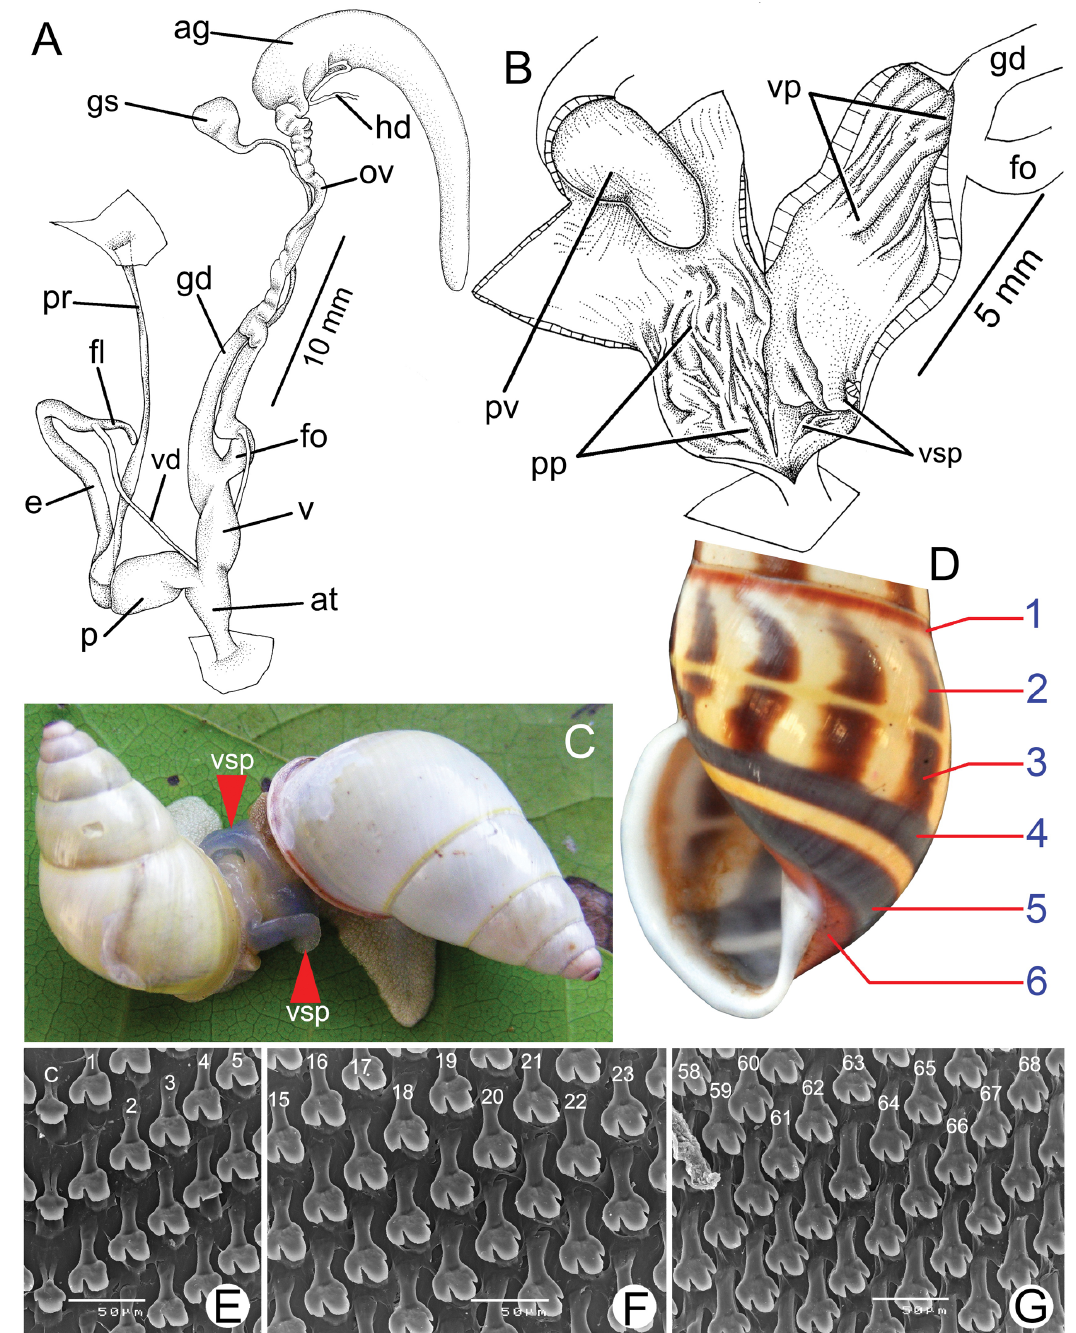
Fig. 8. Genitalia, mating pairs, shell banding formula and radula morphology. A–B . Amphidromus ( Syndromus ) contrarius (Müller, 1774) from Timor (ZMA). A . Genital system. B . Internal structures of penis and vagina. C . Mating pair of Amphidromus ( Syndromus ) sp., showing the protruded vaginal simulator pilaster (vsp, red arrows) and its possible function as a stimulating organ. D . Schematic drawing of shell banding, where the numbers 1 to 6 on the last whorl indicate the position of each band. E–G . Radula morphology of Amphidromus ( Syndromus ) contrarius (Müller, 1774) from Timor (ZMA). E . Central tooth, with the first to fifth lateral teeth. F . Lateral teeth with the tricuspid marginal teeth transition. G . Outermost marginal teeth. Numbers indicate the order of the lateral and marginal teeth. Central tooth indicated by